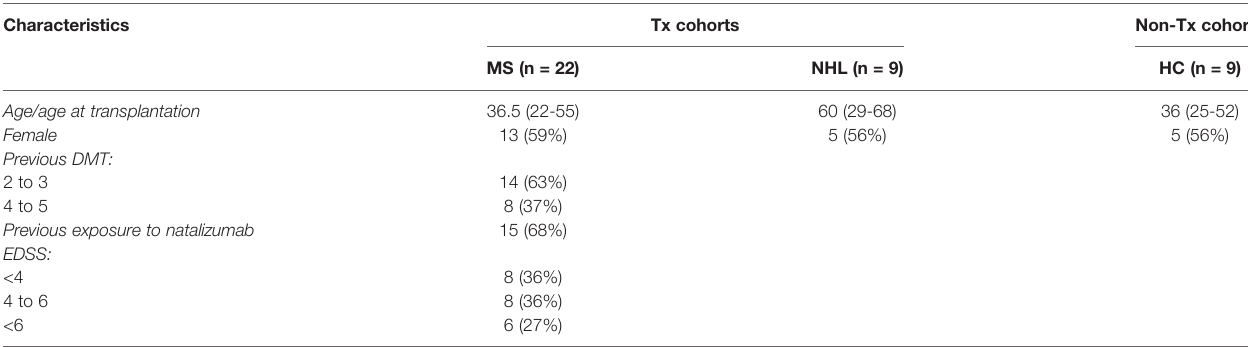
TABLE 1 | Study cohort